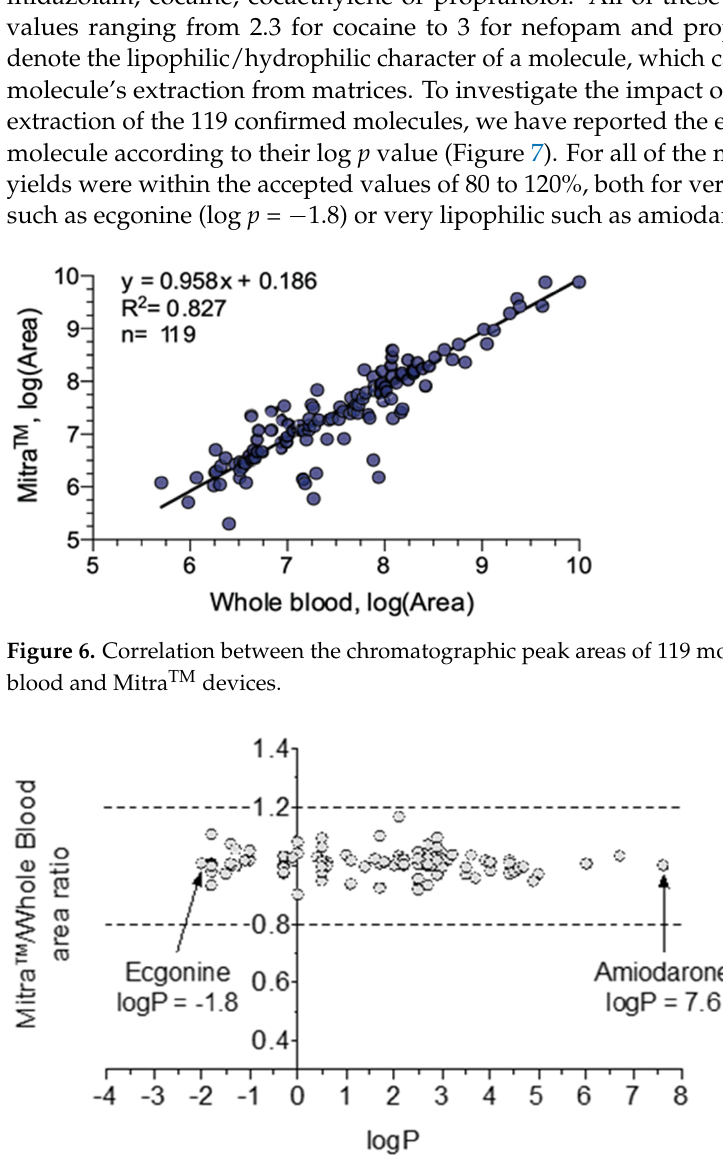
Figure 7. In fl uence of the log p value on the extraction yields of 119 identi fi ed molecules from the Mitra TM devices.